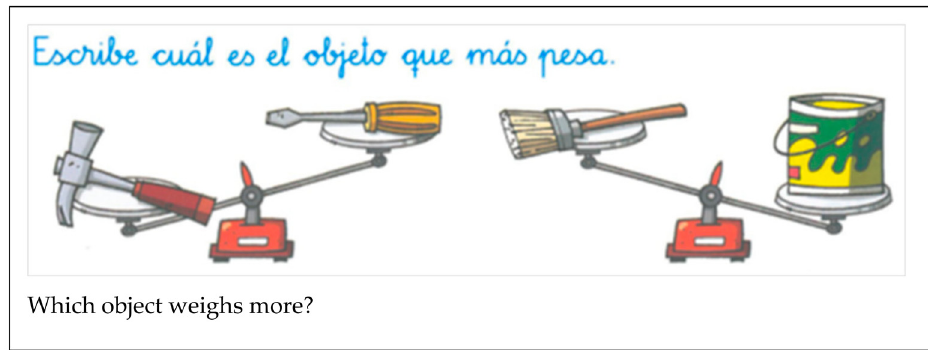
Figure 8. Comparison of mass using tools (first year mathematics, Anaya [48]).